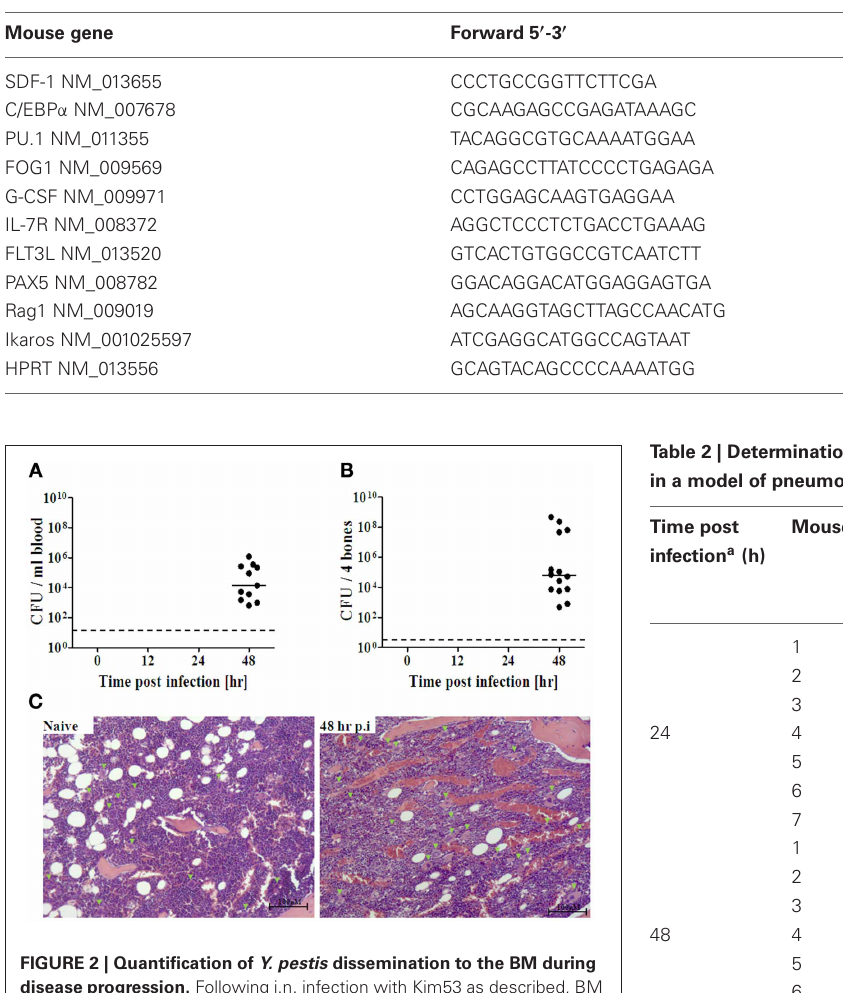
FIGURE 2 | Quantification of Y. pestis dissemination to the BM during disease progression. Following i.n. infection with Kim53 as described, BM extracts (A) and peripheral blood (B) were collected at the indicated time points, and the presence of live bacteria was determined by plating serial dilutions of the samples in PBS on BHIA for 48h at 28 ◦ C. The dashed line indicates the limit of detection. The solid line indicates the average of cfu detected. (C) Representative figures showing H&E staining of femoral bone in naïve and infected mice at 48h post infection (original magnification X10). Green arrowheads point to megakaryocytes. Bar = 100 μ m.